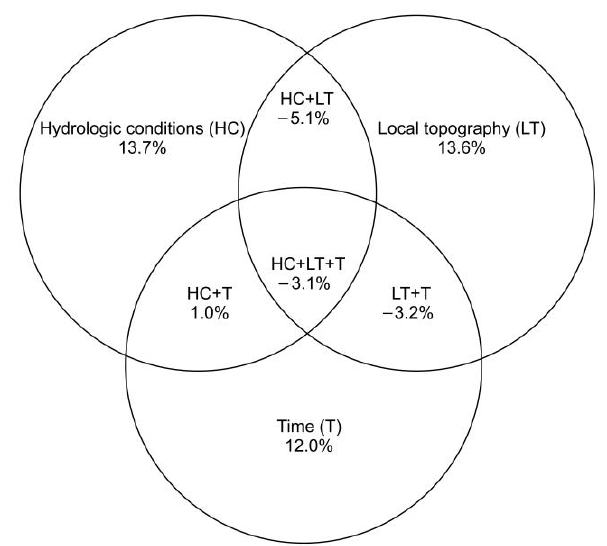
both predictors [57,58] (Figure 4).